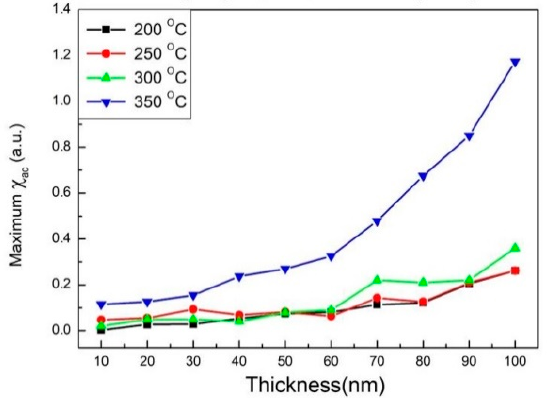
Figure 6. Maximum alternate-current magnetic susceptibility for the CoFeWB films. Table 1. Optimal resonance frequency for films of various thicknesses.